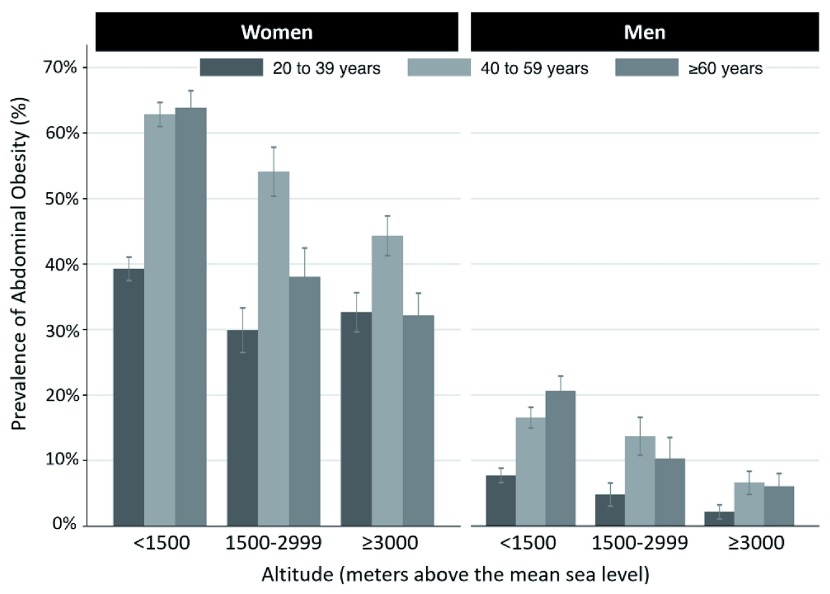
Prevalence of abdominal obesity (by Adult Treatment Panel III guidelines cutoffs) by age group and altitude.The association between abdominal obesity and altitude vary greatly by gender and age group, which behave as effect modifiers.